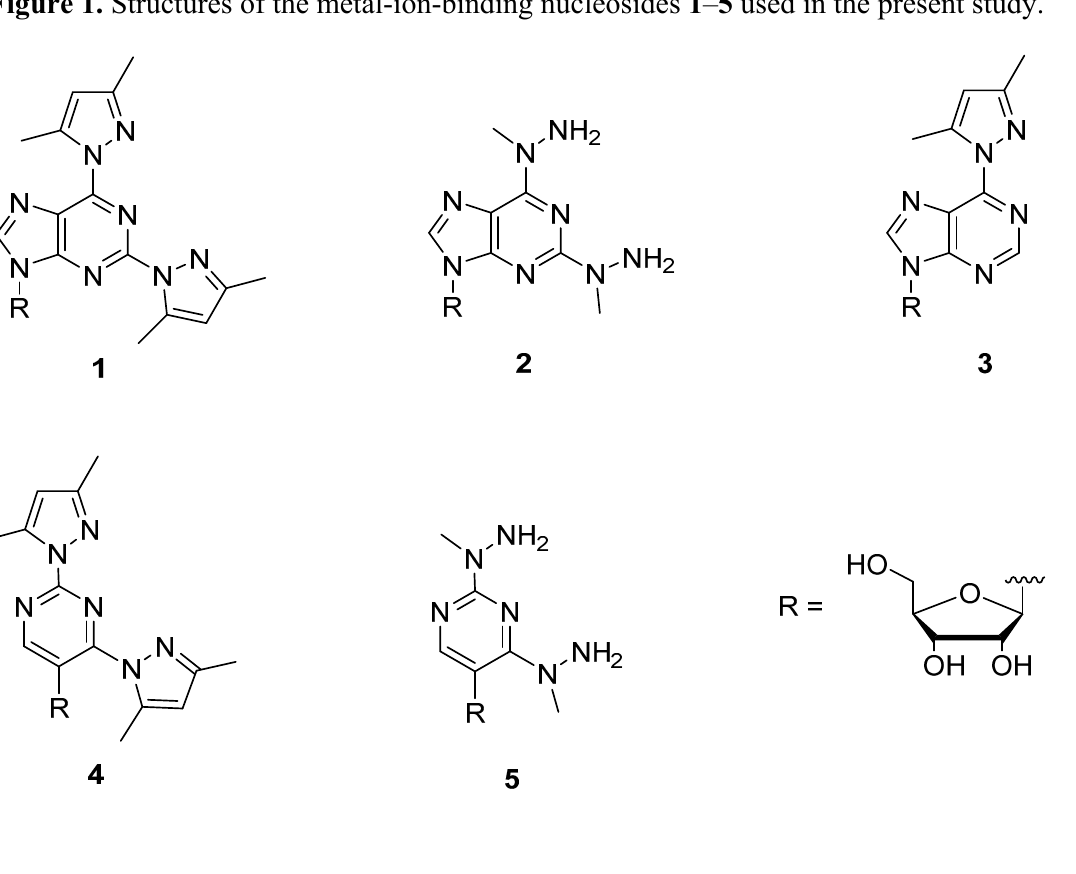
Figure 1. Structures of the metal-ion-binding nucleosides 1 – 5 used in the present